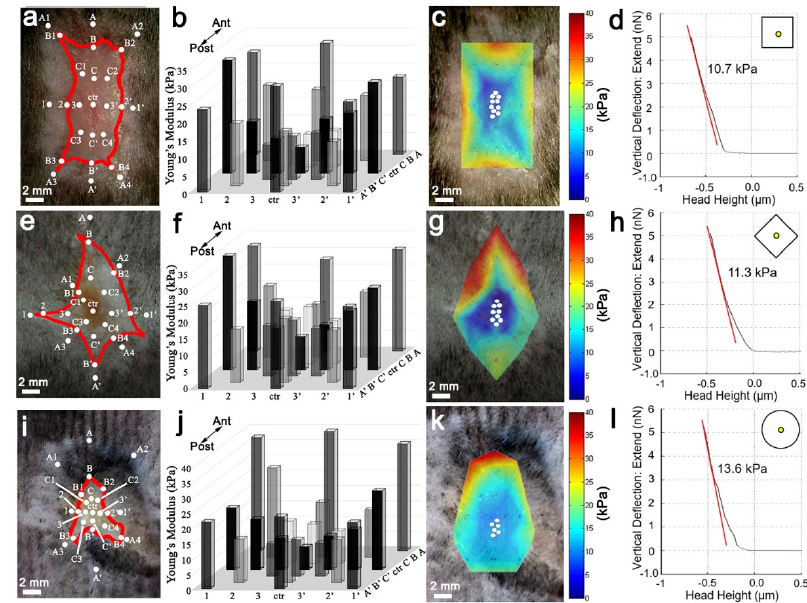
Figure 2. Wound-induced hair follicle neogenesis co-localized with lower stiffness. ( a – l ) AFM measurements for spatial distribution of stiffness at PWD 14. ( a , e , i ) Position of AFM measurements in the wound bed (white dots; AFM position, red line; wound edge, scale bar; 2 mm). ( b , f , j ) AFM quantification of square ( b ), diamond ( f ), and circle ( j ). ( c , g , k ) Overlay of heat map on PWD 14 showing average wound stiffness in square ( c ), diamond ( g ), and circle wounds ( k ) (white dots; de novo follicle positions, scale bar 2 mm). ( d , h , l ) AFM force curve measurements from PWD 14 wound centers in square ( d ), diamond ( h ), and circle ( l ) (red line; slope of linear region of the curve used to calculate Young’s modulus (kPa). Yellow dot in wound shape at top right corner of graph; force curve measurement site. The AFM cantilever spring constant is 0.08 N/m, with a 25 μ m diameter bead tip, and 5 nN indentation force).